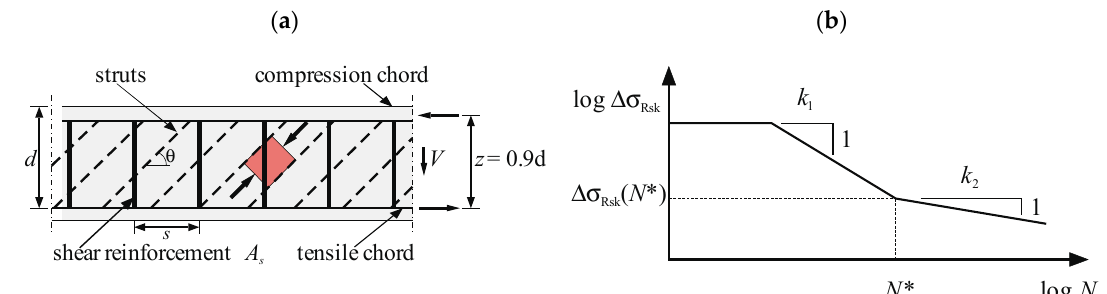
Figure 8. ( a ) Truss model for beams with shear reinforcement; ( b ) Characteristic S–N curve for reinforcing steel (both according to [8,9]).